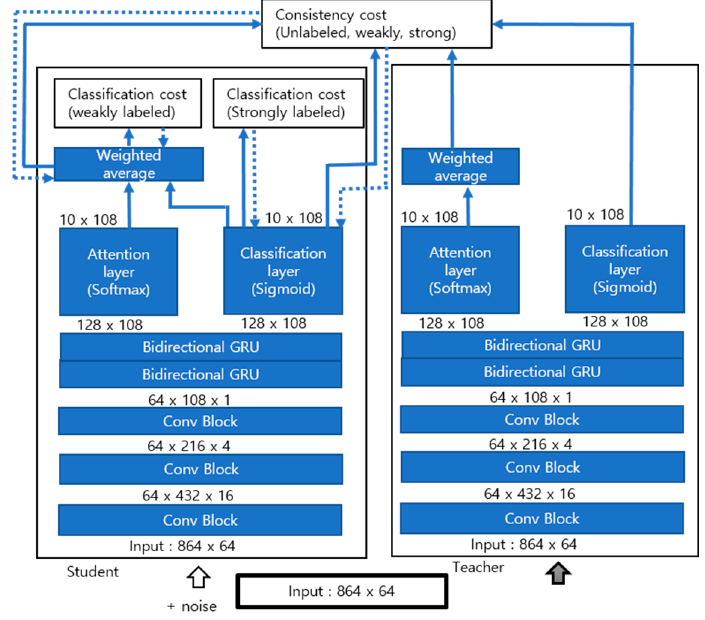
Figure 3. Structure of the mean-teacher model.